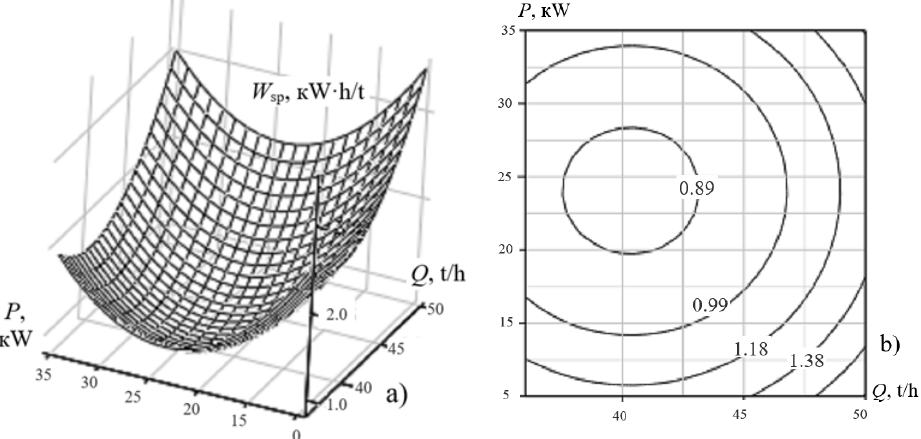
Figure 4. Response surface of the target function ( a ) and its two-dimensional cross-sections ( b ) for ZAV-40 at х 3 = 0.